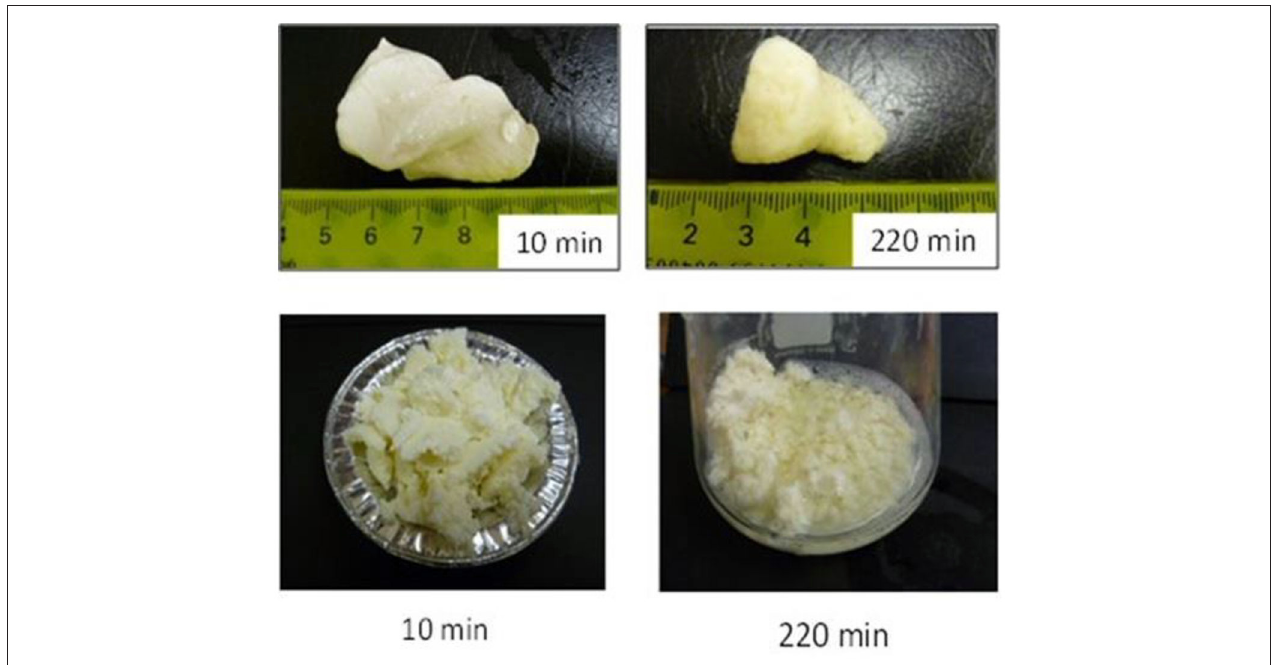
FIGURE 2 | Images of clots formed during the gastric digestion of 200g of unheated (top row) and heated (bottom row) cattle skim milk at different digestion times. Source: Adapted from Ye et al. (107).